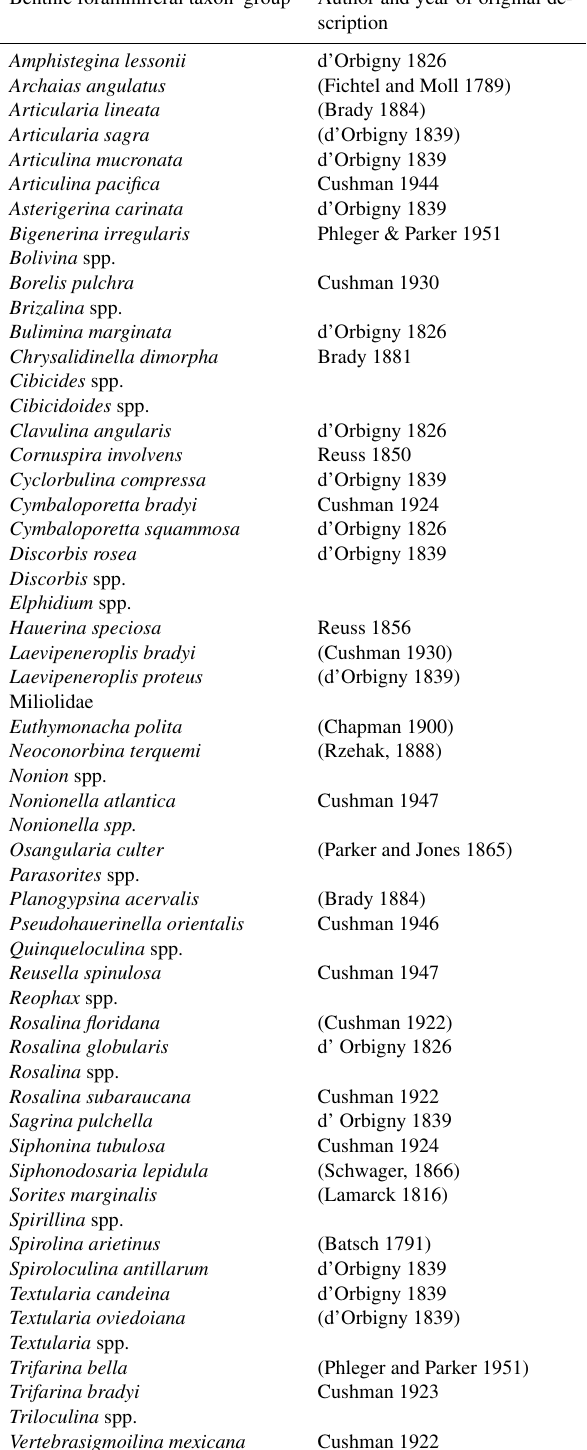
Table 5. List of benthic foraminiferal species and author names en- countered in the biocoenosis and thanatocoenosis in surface sedi- ments and on macrophytes from Grahams Harbour, San Salvador